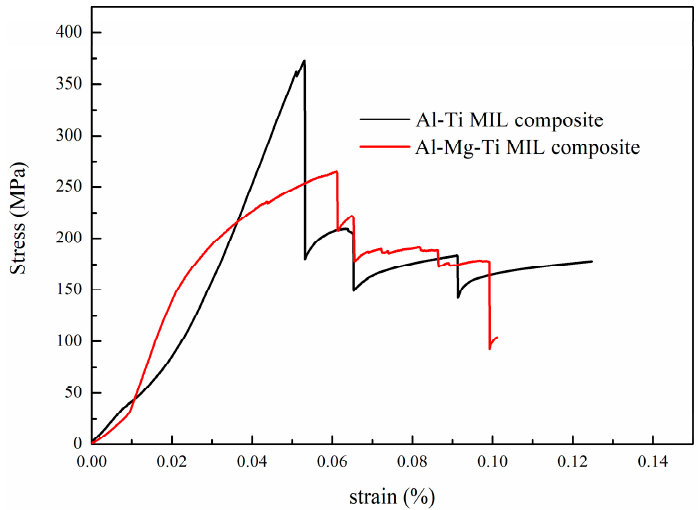
Figure 5. The stress–strain curves of AlTi-based and AlMgTi-based MIL composites. Table 2. Density and specific strength of AlMgTi-based and AlTi-based MIL composites Samples Density Specific Strength (g/cm 3 ) （ ×10 3 Nm/kg ） AlMgTi-based MIL composite 2.51